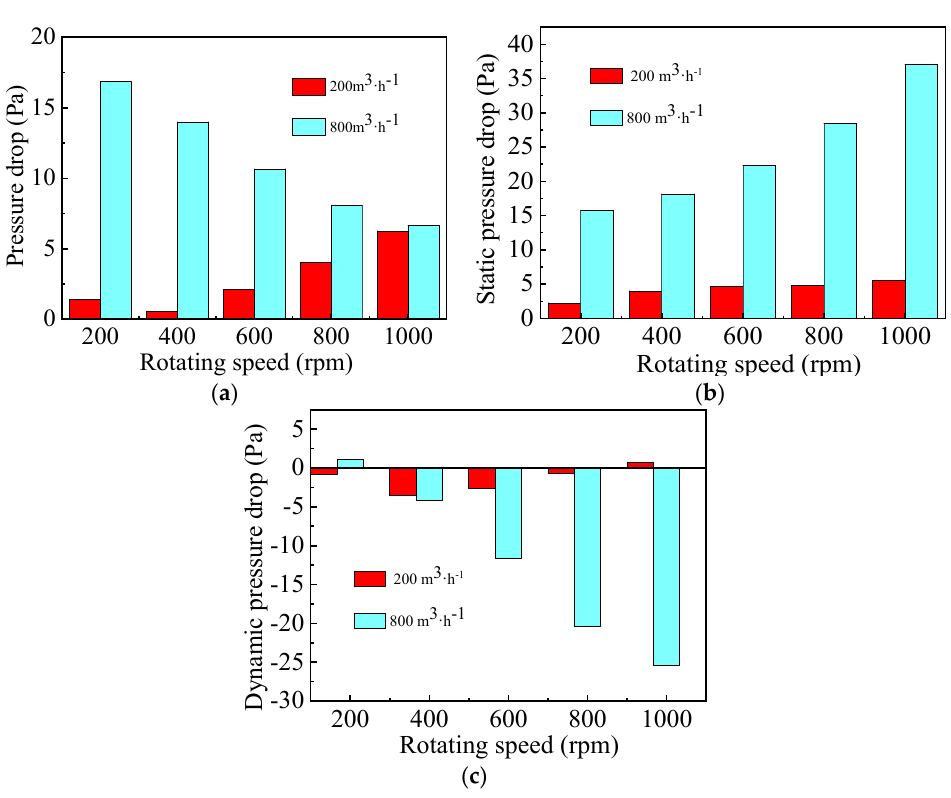
Figure 7. The effect of the rotating speed on the pressure drop in the packing zone. ( a ) Pressure drop; ( b ) static pressure drop; ( c ) dynamic pressure drop.